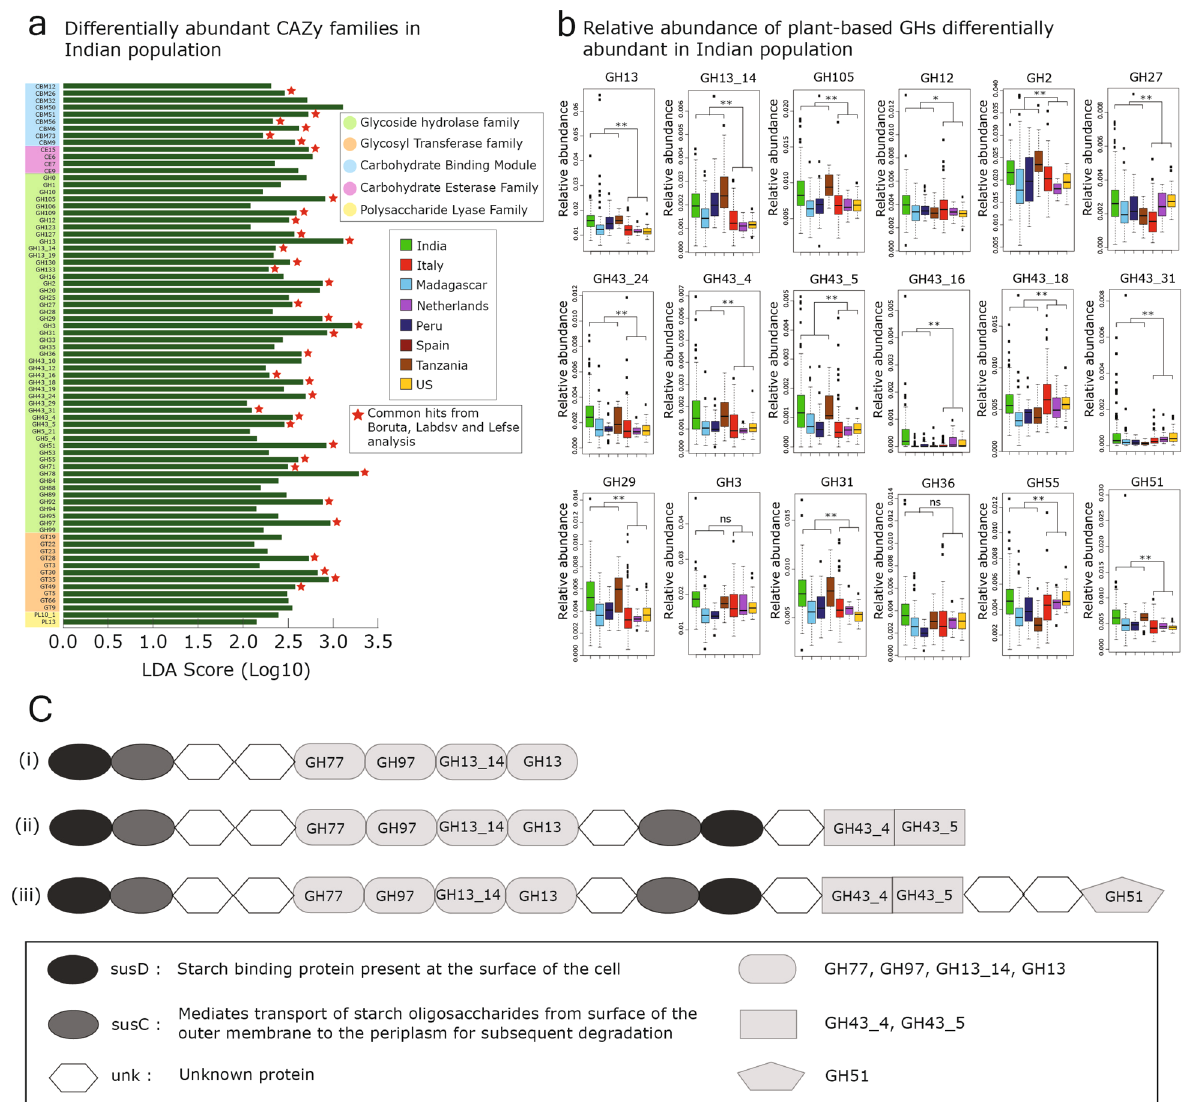
Fig. 6 Abundance of plant carbohydrate metabolizing enzymes of Prevotella genus in Indian and other non-western populations. a Discriminating carbohydrate metabolizing gene families (CAZy families) of Prevotella in the Indian cohort compared to all other populations together (Italy, Netherlands, US, Madagascar, Peru, and Tanzania) identi fi ed based on LDA score (using LEfSe). The legend shown on the right side depicts the broad classi fi cation of CAZy families. The CAZy families highlighted with a red-colored star are the ones that were detected in all three statistical methods for fi nding differentially abundant CAZy families (LEfSe, labdsv, and boruta). b Relative abundance of all differentially abundant plant-based Glycosyl Hydrolases (based on studies mentioned in Supplementary Data12, sheet 2) in all populations. The whiskers, bound of the box, and the line in the middle of the box represent the min-to-max values, 25th – 75th percentiles, and median, respectively. A nonparametric two-sided Wilcoxon rank-sum test was used to test the box-plot distributions. ns refers to “ not signi fi cant ” , * indicates p -value < 0.05 and ** indicates p -value < 0.01. c Pullulanase-containing-PULs were detected in 782 out of 1023 P. copri genomes. The most frequent PUL among them is susD-susC-unk-unk-GH77-GH97-GH13_14-GH13 shown as (i) is present in 113 genomes (with the same arrangement of CAZy families). The second most frequent pullulanase-containing-PUL has GH43_4 and GH43_5 shown as (ii) with the aforementioned CAZy gene families and is present in 93 genomes (with the same arrangement of CAZy families). Other pullulanase- containing-PULs have GH51 with GH77, GH97, GH13_14, GH13, GH43_4, and GH43_5 at the same genomic loci shown in (iii) and are present in 21 genomes (with the same arrangement of CAZy families). The majority of the remaining pullulanase-containing-PULs have the same gene families with different arrangements (see Supplementary Notes-part 10 and